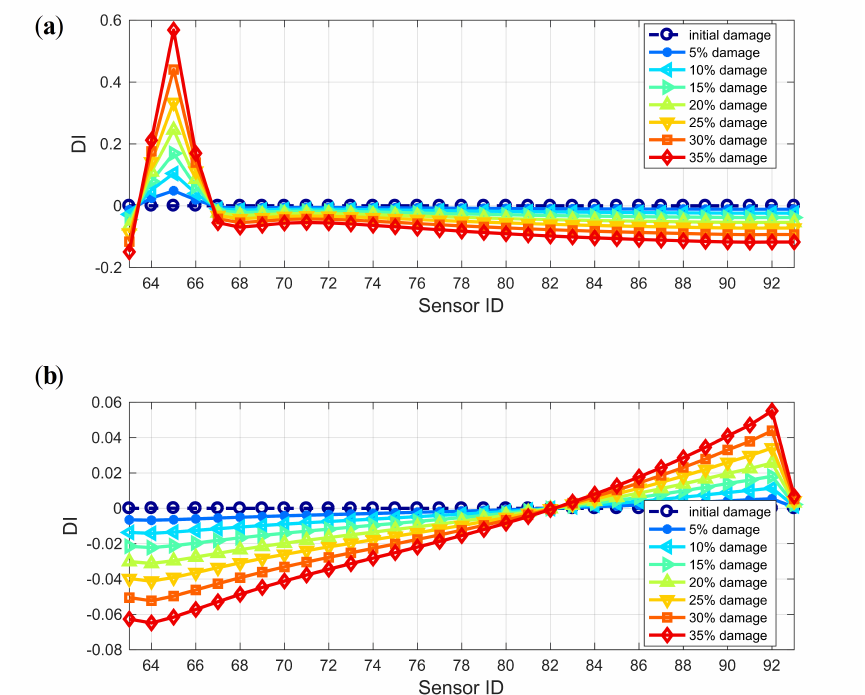
Figure 14. Damage identification results of the CCGB using WPE-based index DI: ( a ) Damage I; ( b ) Damage